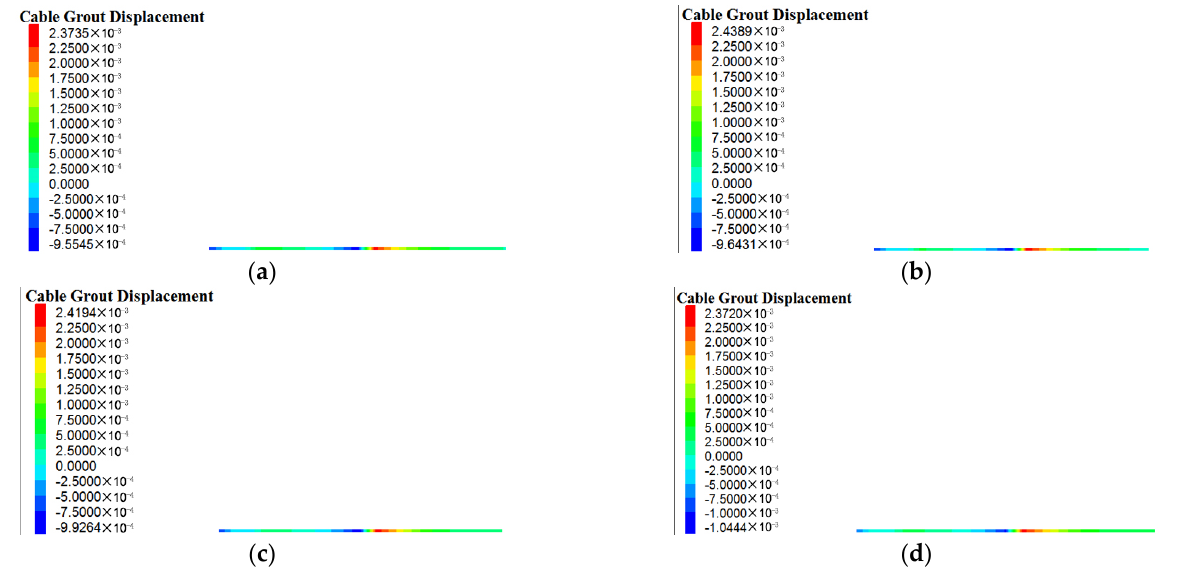
Figure 7. Cloud image of the cable displacement under different L a (with a fracture aperture of 4 mm). ( a ) L a = 400 mm; ( b ) L a = 600 mm; ( c ) L a = 800 mm; ( d ) L a = 900 mm.